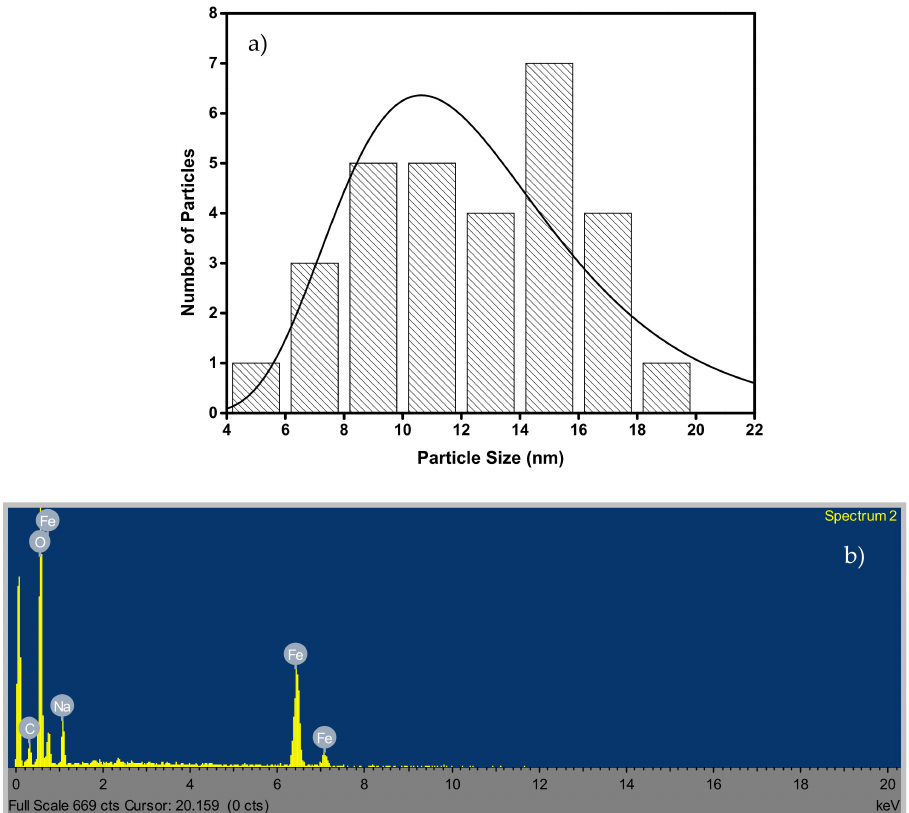
Figure 3. Particle size distribution ( a ) and EDX ( b ) of iron oxide nanoparticles. The EDS spectrum (Figure 3b) indicates the presence of Fe, C, O and Na. The presence of Na results from the precursor (NaBH 4 ) used during synthesis. Moreover, the elemental composition of the IONPs is Fe (36.5%), C (12.3%), O (45.2%), and Na (6.0%). The IR spectrum of the synthesized IONPs is shown in Figure 4. The broad absorption band at 3406 cm − 1 is the characteristic stretching vibration of –OH group, which is a function of the water adsorbed during synthesis [35]. The band at 1638 cm − 1 may be ascribed to OH bending vibration and the characteristic peak 448 cm − 1 and 686 cm − 1 is assigned to the stretching vibration of Fe-O band.